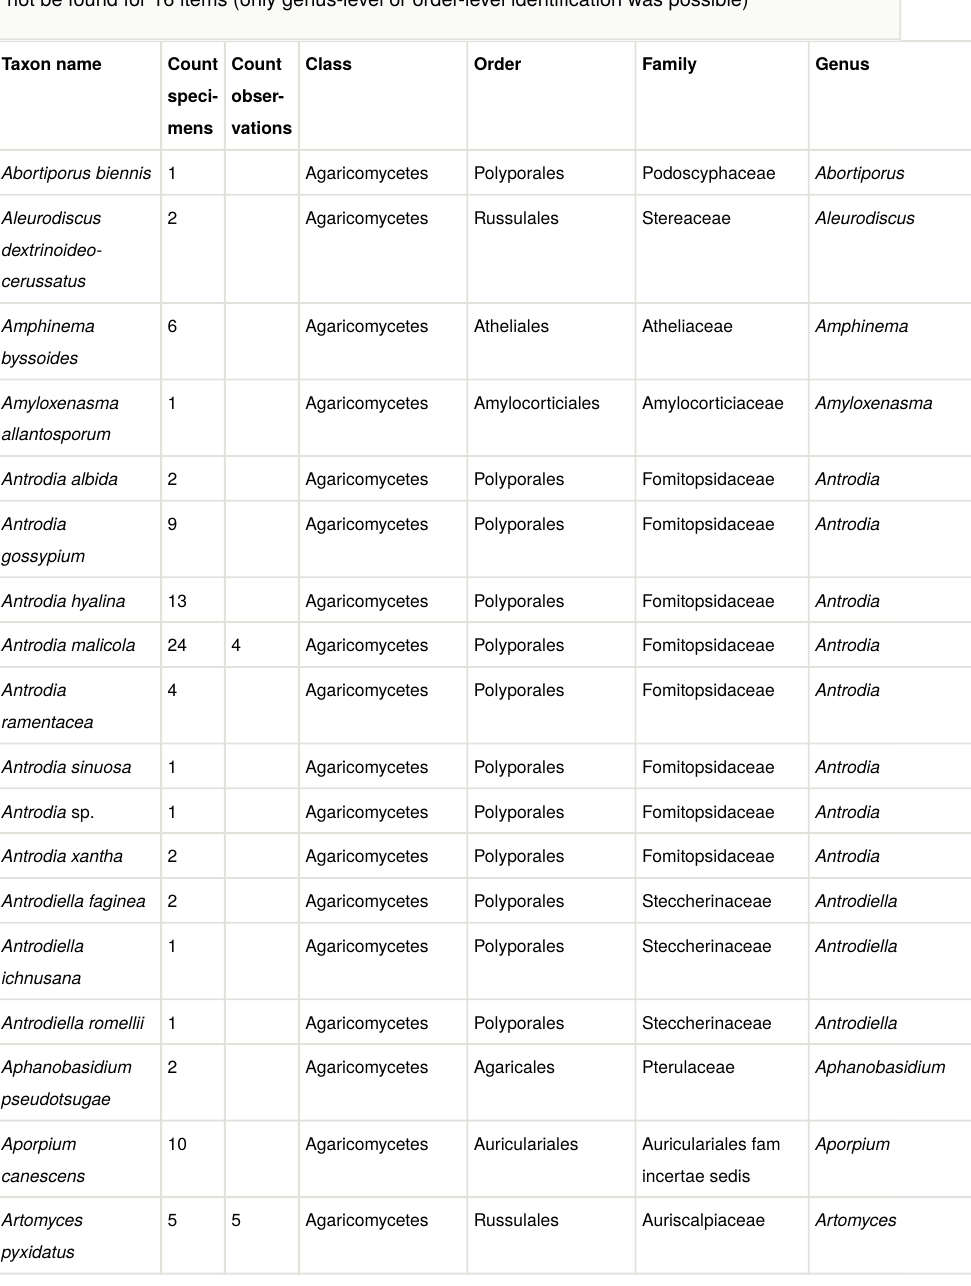
Table 3. Species checklist and frequencies of occurrence of aphyllophoroid fungi (phylum Basidiomycota ) from insular woodlands of eastern Ukraine. Speci fi c epithet is available for 349 taxa, while it could not be found for 16 items (only genus-level or order-level identi fi cation